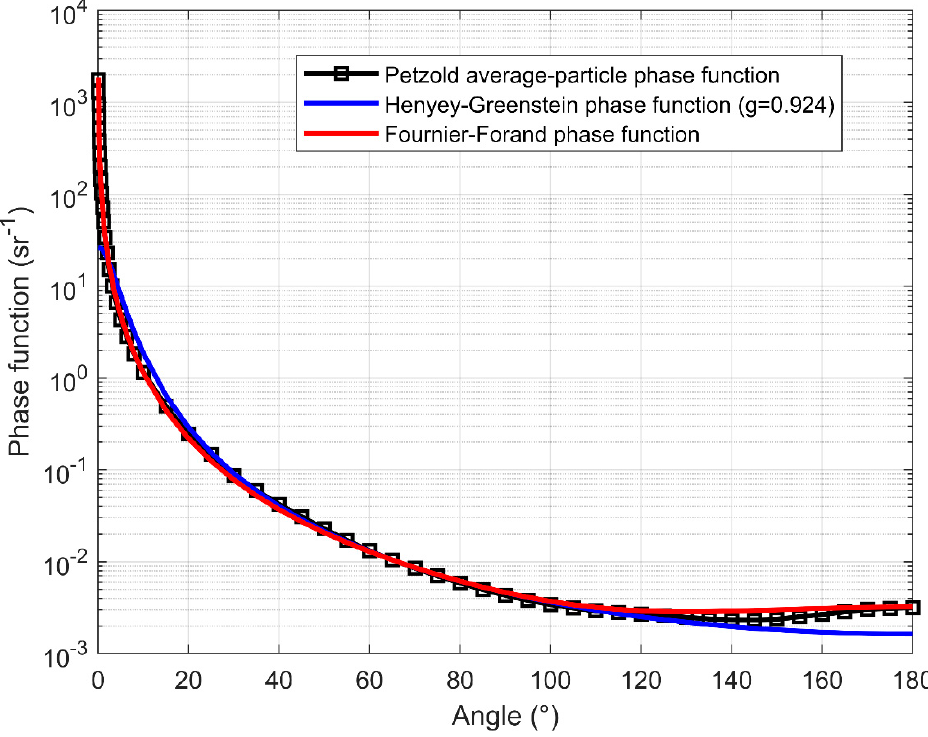
Figure 1. Log-linear plot of various scattering phase functions. The black curve is the standard phase function measured by Petzold. The red curve shows the Fournier-Forand phase function with the same backscatter fraction as the measured phase function. The blue curve presents the Henyey-Greenstein phase